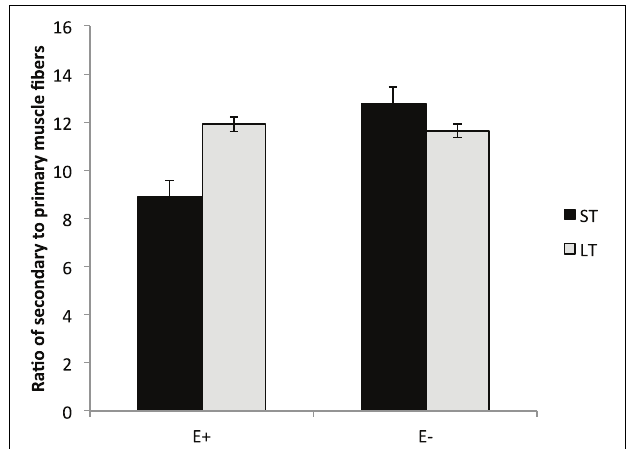
FIGURE 4 | Secondary to primary muscle fiber ratio in the longissimus thoracis (LT) and semitendinosus (ST) muscles in lambs from dams fed tall fescue seed containing endophyte (E + ) vs. endophyte-free (E − ) during gestation. Treatment was significant ( P = 0.002) for ST muscles but non-significant for LT ( P = 0.57).